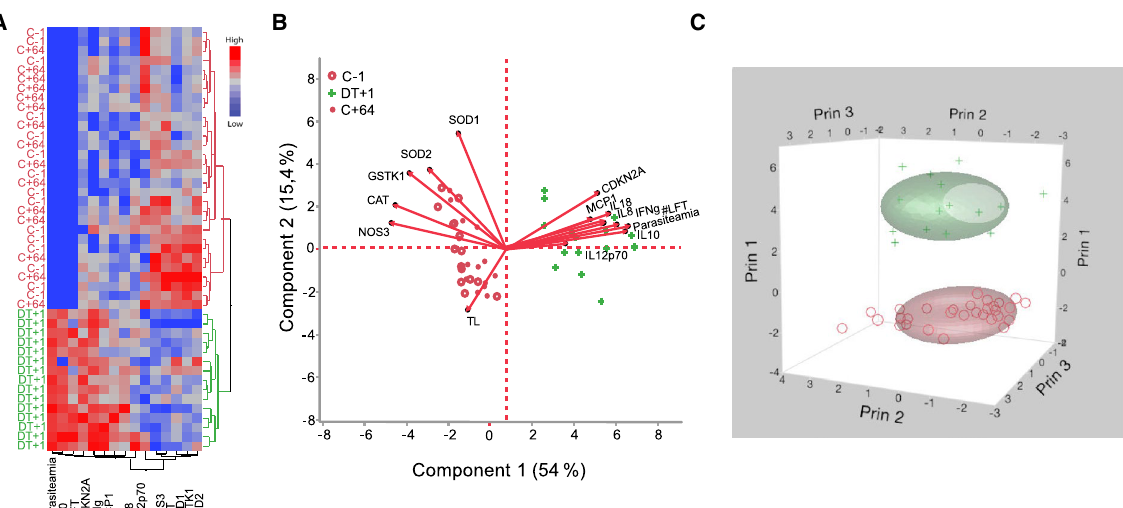
Figure 3. Heatmap and Principal Component Analysis (PCA) showing clusters of cellular aging markers (telomere length, telomerase activity and CDKN2A expression), inflammatory cytokines and anti-oxidant gene expression. ( A ) Heat-map displaying results of our hierarchical cluster analysis and differential expression level of grouped study variables at time points C-1, DT+1 and C+64. TL = telomere length, #LFT = liver function test abnormality score, CDKN2A = cyclin dependent kinase inhibitor 2A. ( B ) 2D PCA, separating cytokines, anti-oxidants, and TL during time points C-1 (red circles), DT+1 (green plus symbol), and C+64 (red dots). ( C ) K-mean cluster separating variables into three PC axes (Prin1-3) to visualize the separation between time point C-1 and C+64 (red circle) from DT+1 (green plus-symbol). Data visualization is based on analysis in Stata